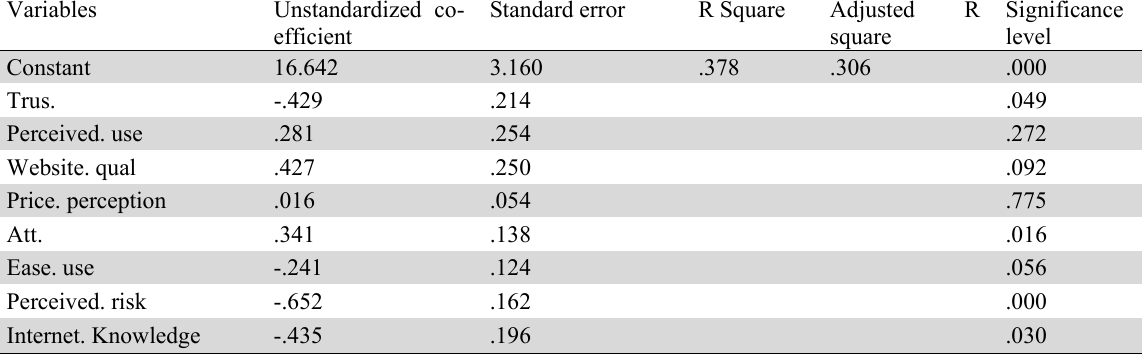
Relationship between explanatory variables and adoption of air ticketing Variables Unstandardized co-